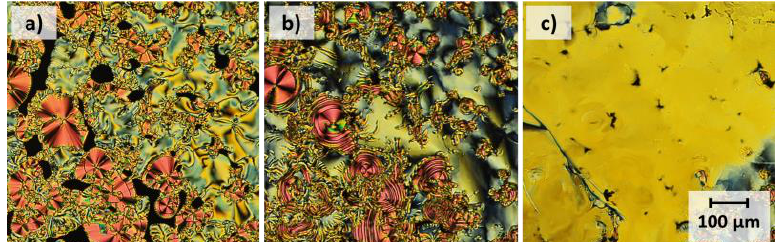
Figure 3. POM of Th-Thd-Th(10) showing schlieren and focal-conic textures of the SmC phase at 125.0 °C ( a ), modified textures of the CrJ phase at 91.0 °C ( b ), and changes upon cooling to the crystalline phase at 79.0 °C ( c ).